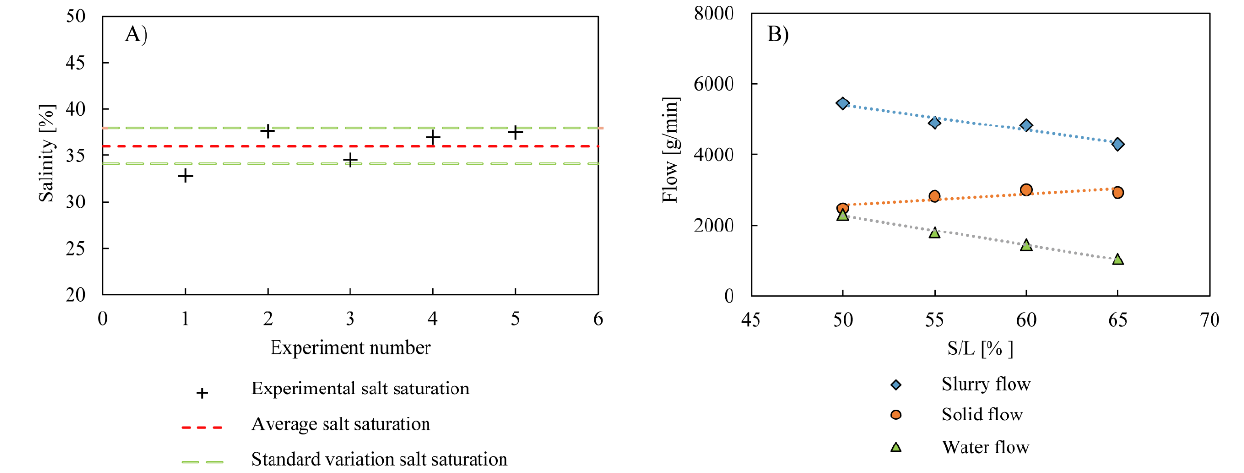
Figure 5. Results of calibration experiment, showing ( A ) Salt saturation ratio, ( B ) Flows control .